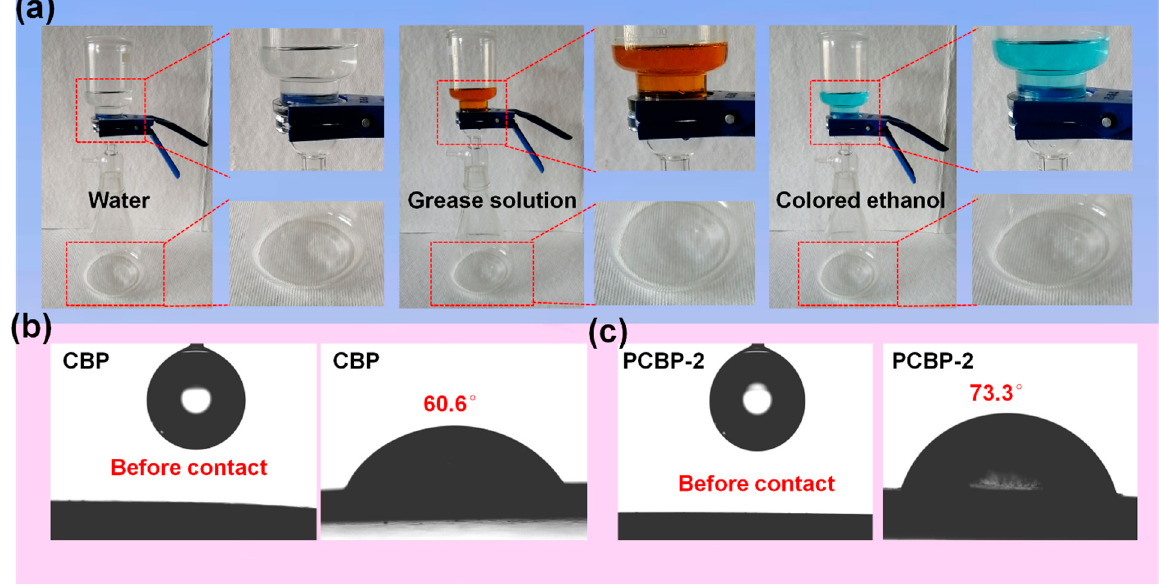
Figure 5. ( a ) Photographs of barrier properties of PCBP-2 after 30 days of contact. Water barrier of PCBP-2 ( left ), oil barrier of PCBP-2 ( middle ), and ethanol barrier of PCBP-2 ( right ). ( b , c ) Water contact angle of CBP and PCBP-2.